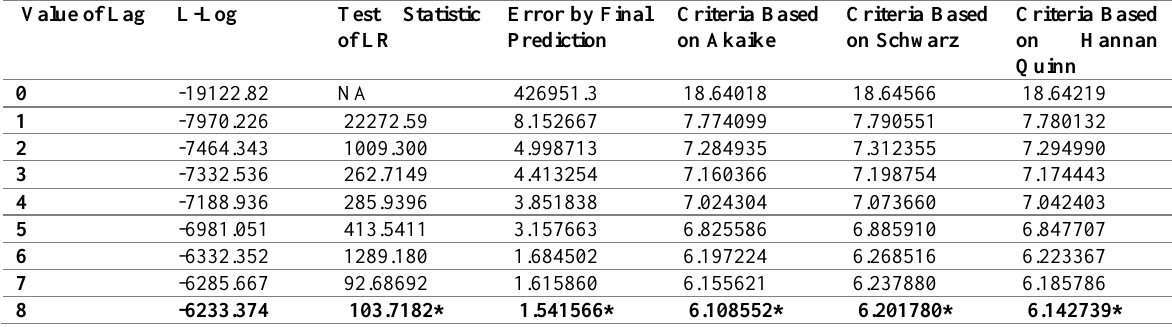
Table 7: Result of Optimal Lag Selection of Private Banks